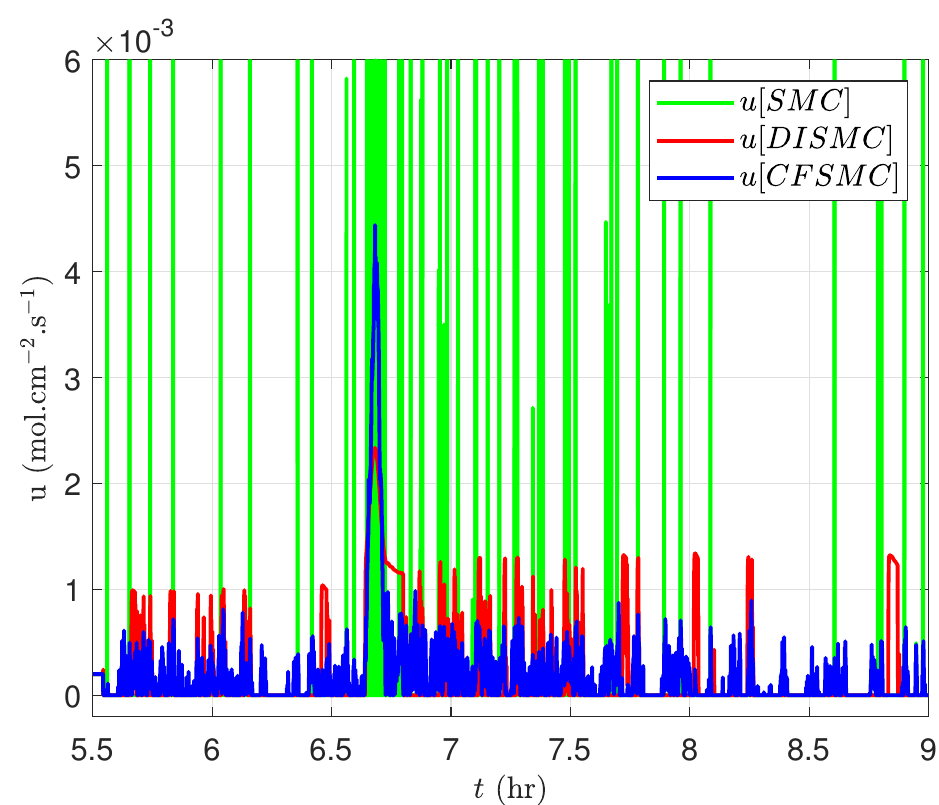
Figure 4. Control input for different controllers with time.